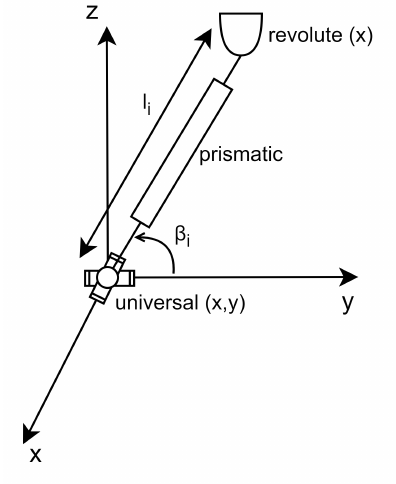
Figure 5. Kinematic chain of the i th limb of the